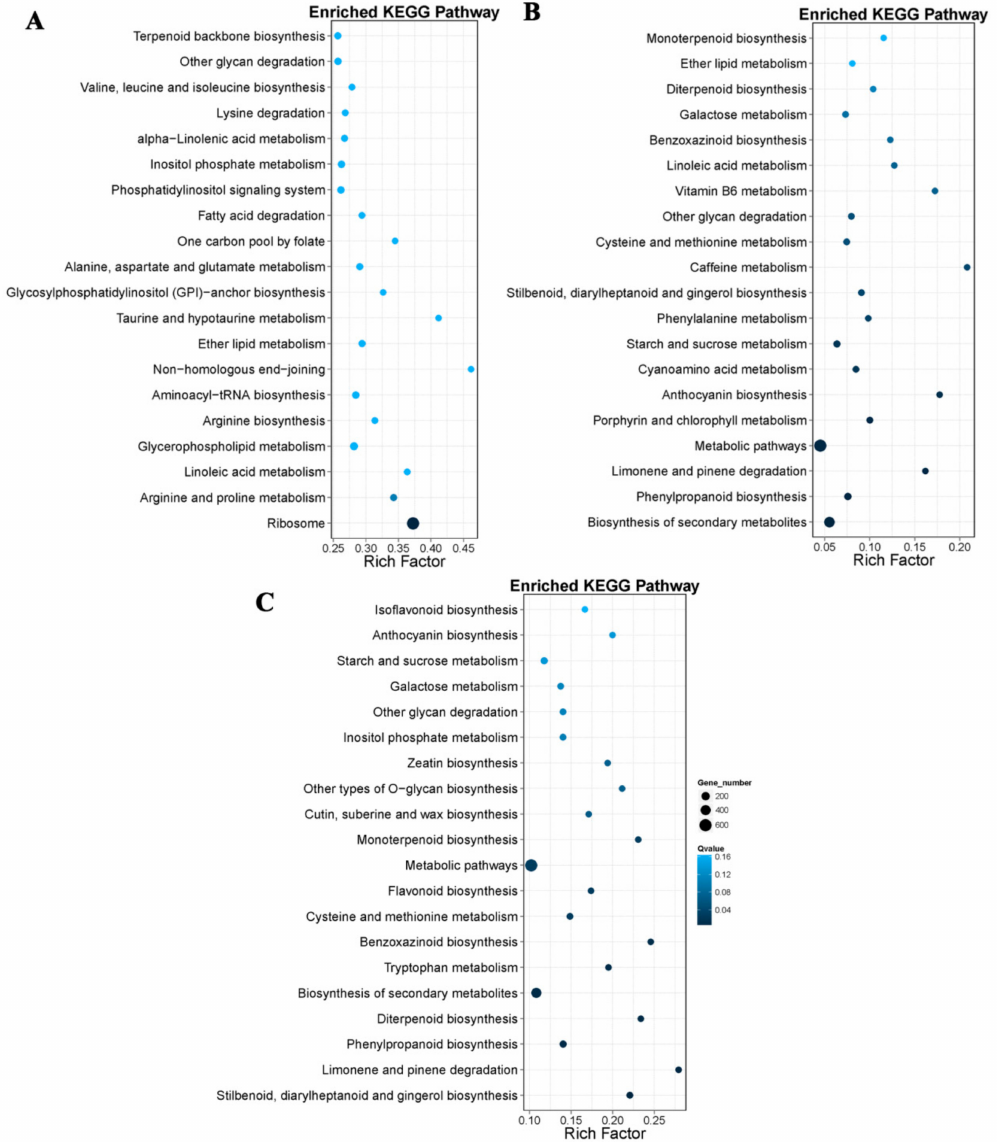
Figure 5. Statistics of pathway enrichment of DEGs in CML530 vs. QCL8011_2 at 18 DAP ( A ), 28 DAP ( B ), and 38 DAP ( C ). X axis means Rich Factor, and Y axis represents second KEGG pathway terms. Rich Factor is the ratio of the di ff erentially expressed gene numbers annotated in this pathway term to all the gene numbers annotated in this pathway term. Greater Rich Factor means greater intensiveness. Q value is corrected p value ranging from 0 to 1, and less Q value means greater